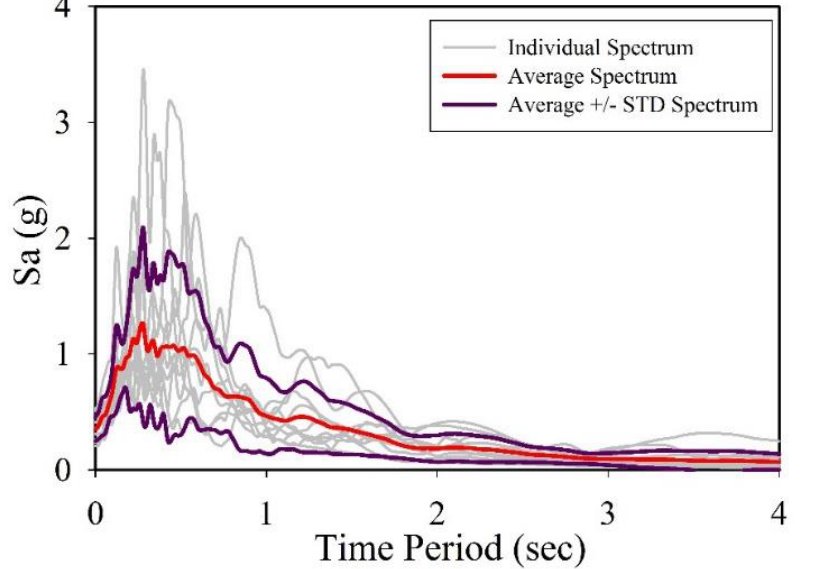
Fig. 10. The Sa(g) of applied records vs. time